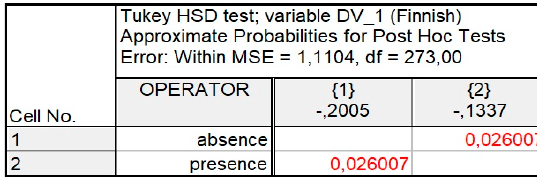
Figure 10. Operator post hoc results (Finnish).